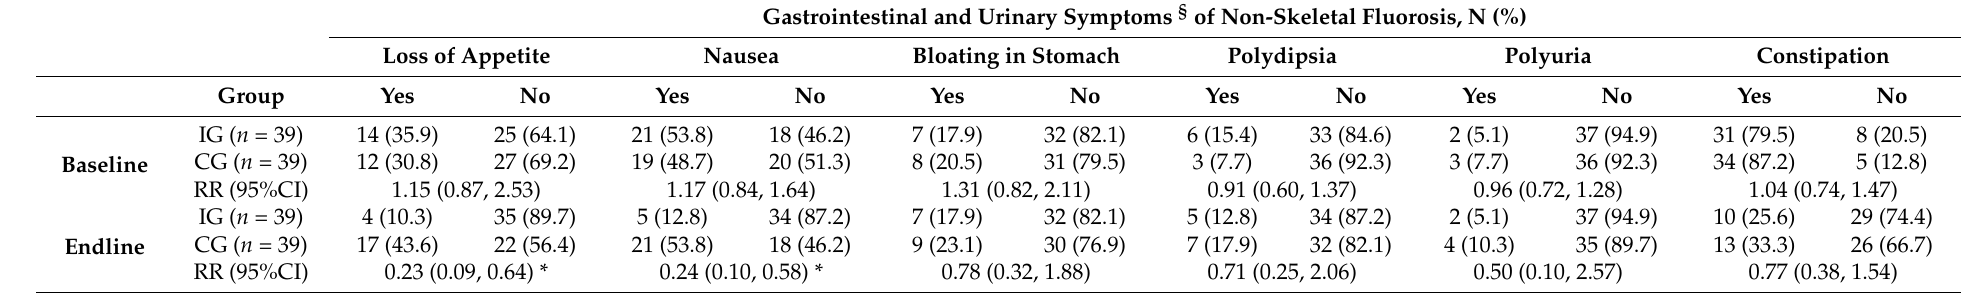
Table 6. Gastrointestinal and urinary symptoms of non-skeletal fluorosis in a 6-month eggshell powder intervention in treatment and control groups. Gastrointestinal and Urinary Symptoms § of Non-Skeletal Fluorosis, N (%) Loss of Appetite Nausea Bloating in Stomach Polydipsia Polyuria